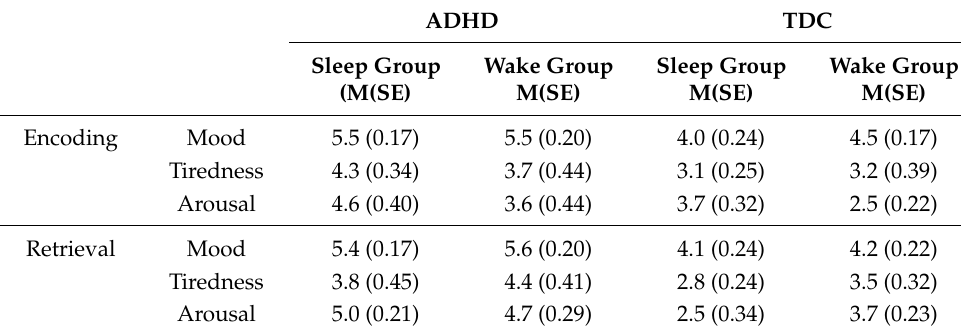
Table 6. Ratings of mood, tiredness, and